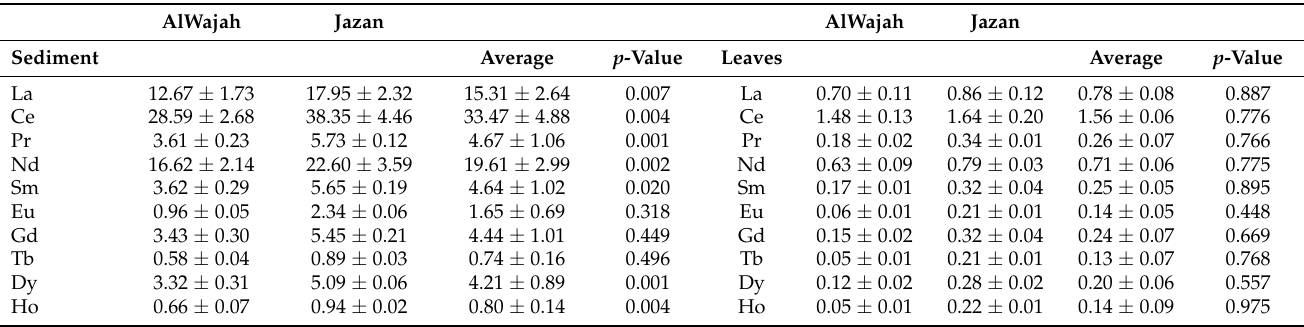
Table 1. Rear earth elements’ composition (mg/kg) and fractions in northern and southern central Red Sea